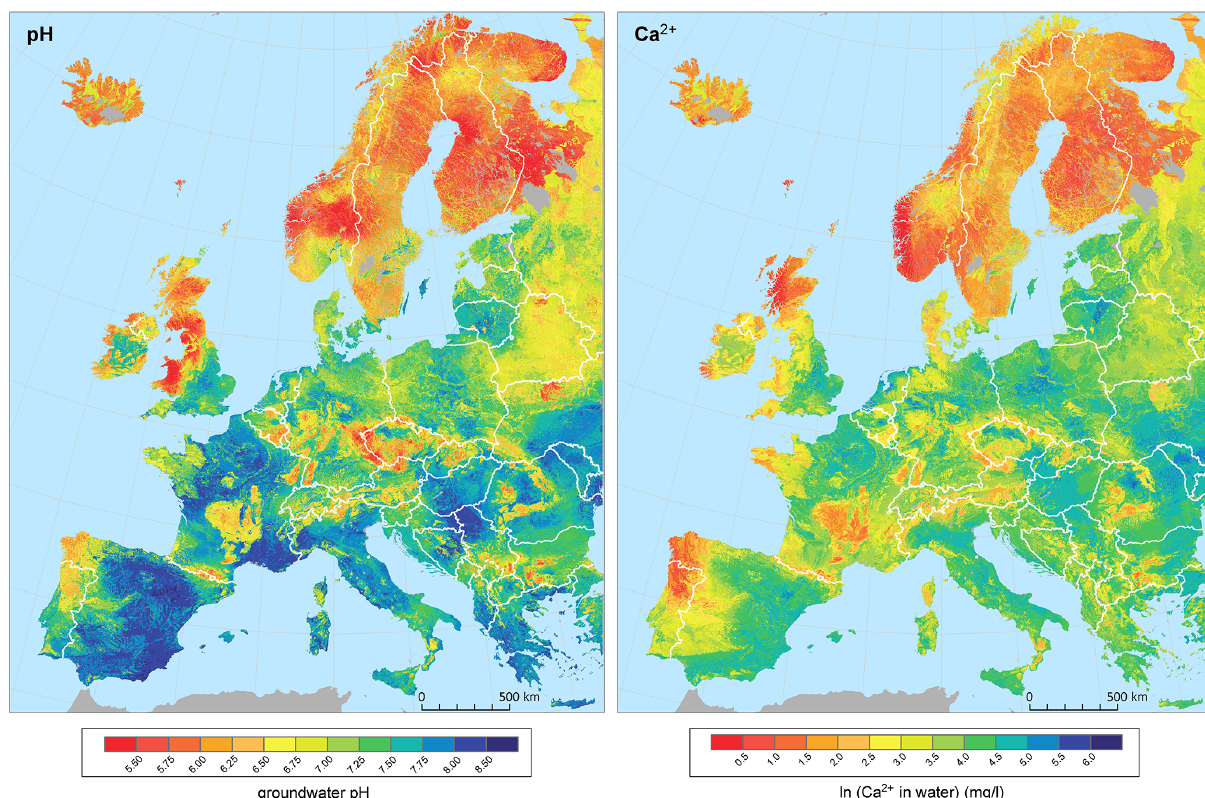
Figure 5. Model predictions based on regression kriging. Note that the Ca 2 + concentration is on an ln scale. The map was created entirely by the authors with state borders from ArcGIS® version 10.2 (Esri, Redlands, CA,